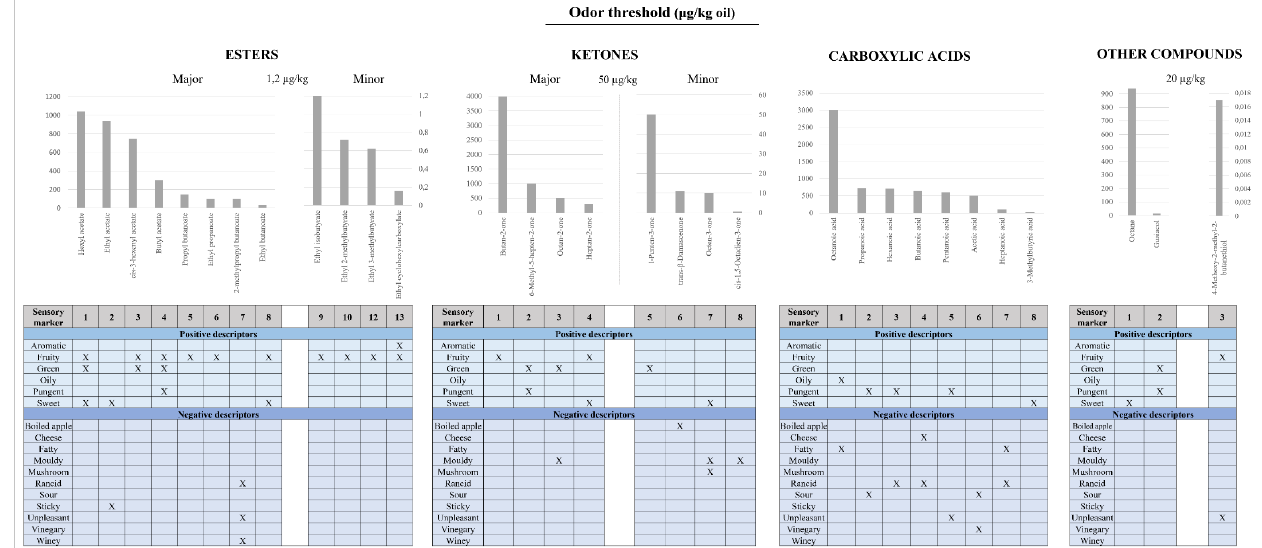
Figure 2. Odor thresholds and sensory descriptors of esters, ketones, carboxylic acids, and other compounds in olive oil. The major volatile compounds found in EVOO belong to C6 and C5 compounds